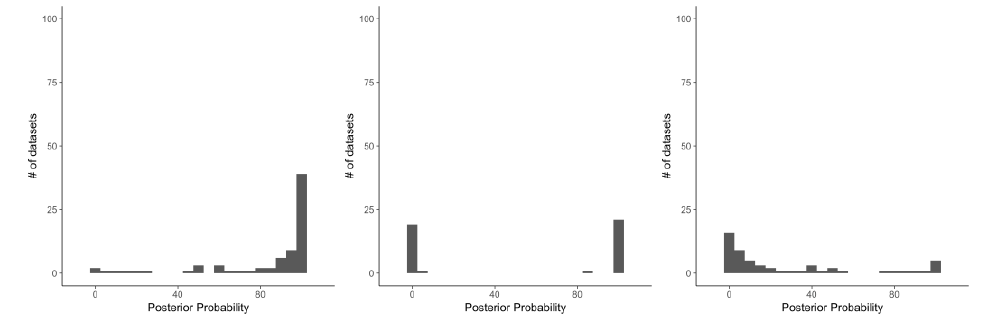
Fig. 8. Distributions of posterior probabilities between Output and Enquiry in China dataset when the